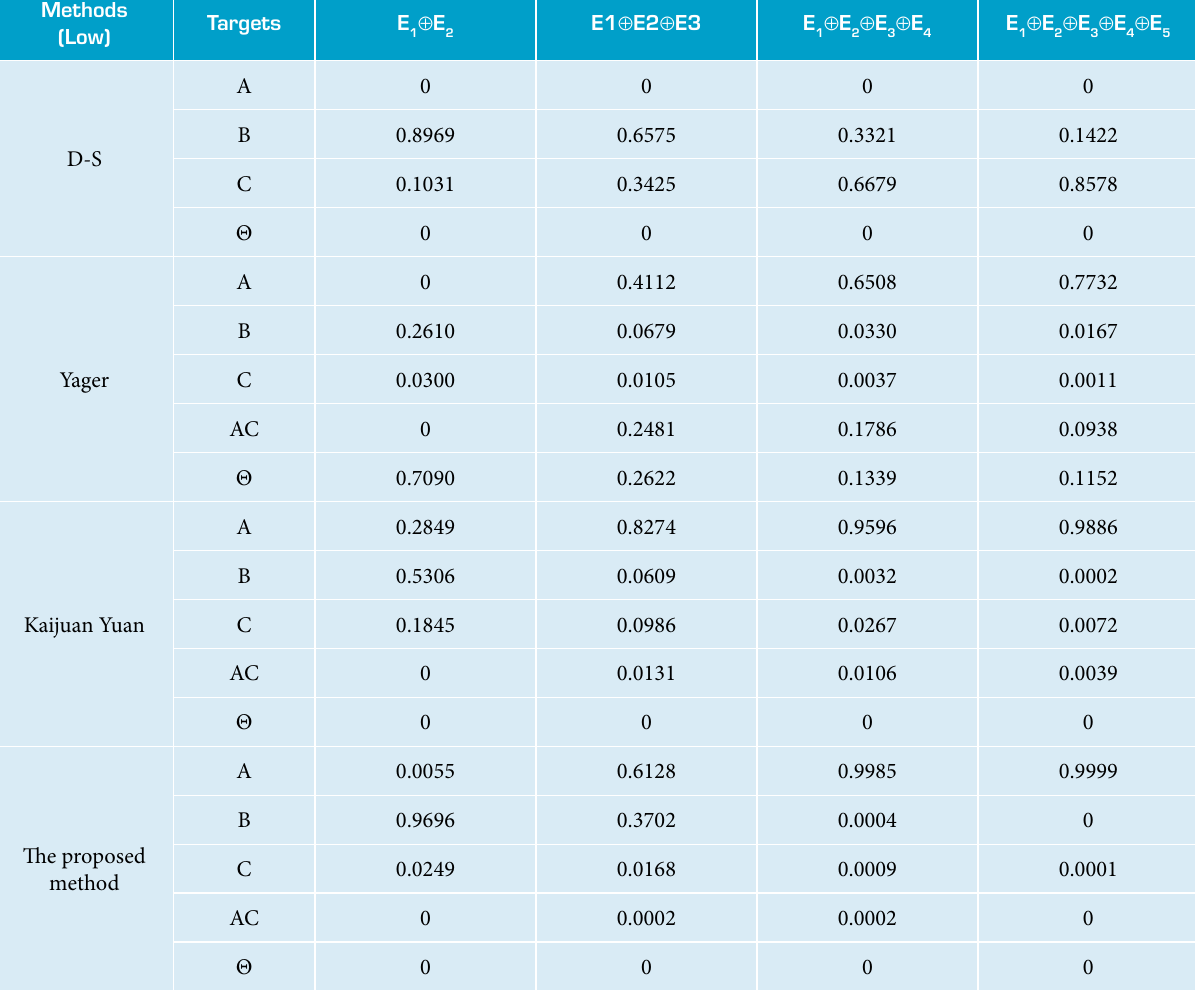
Table 6. Fusion results of different methods with multi-elements